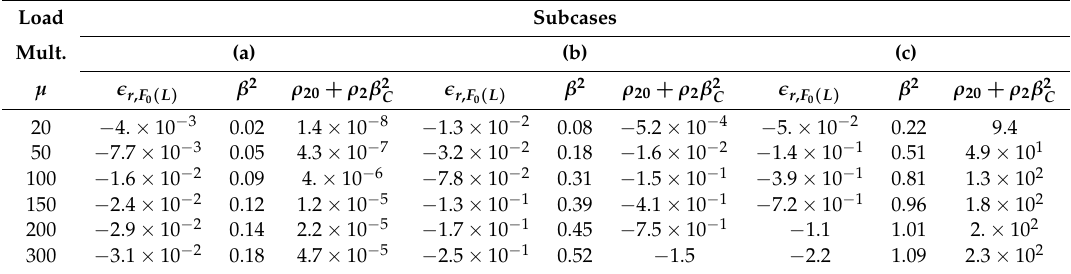
, Searle parameter β 2 = B 2 / R 0 H = 0 ( L ) in Equation (8). C